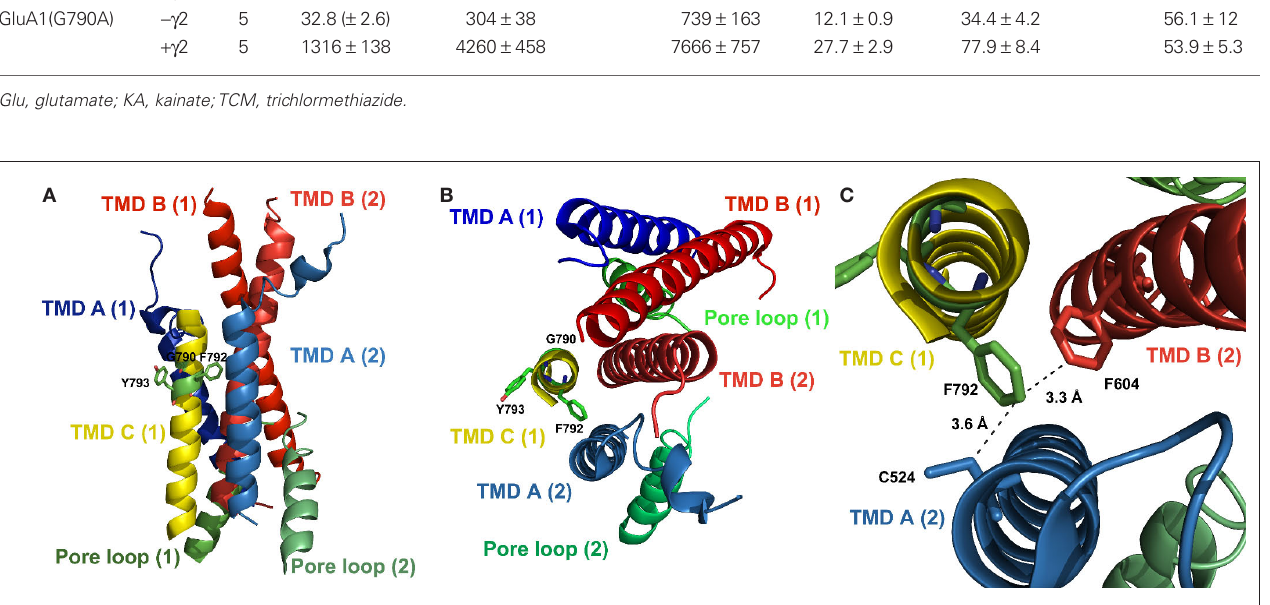
FiguRe 6 | Localization of the residues discussed here in the crystal structure of gluA2 (PDB# 3Kg2), with residue numbering, however, referring to the respective positions in gluA1. (A) Side view; (B) Top view; shown are the TMDs and the pore loop of two subunits of the tetramer as indicated by numbers in brackets; the TMD C of the second subunit was omitted for clarity. Side chains of residues investigated in this study are